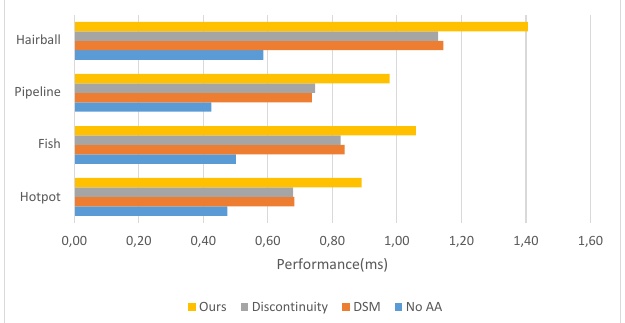
Figure 10. The performance (ms) of several anti-aliasing methods at different